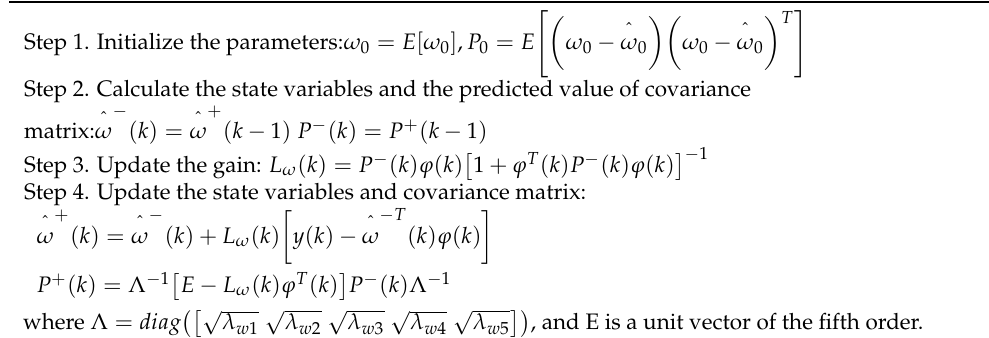
Table 2. Parameter identification process of VRLS